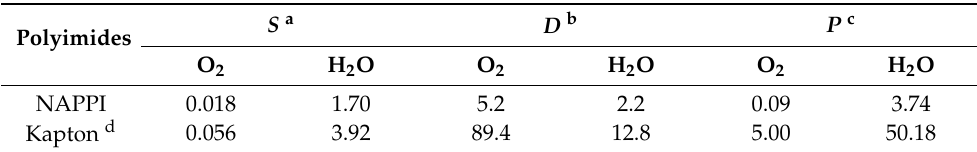
Figure 13. Sorption sites of O 2 and H 2 O in NAPPI and Kapton. Table 5. Solubility coefficients, diffusion coefficients and permeability coefficients for H 2 O and O 2 in NAPPI and